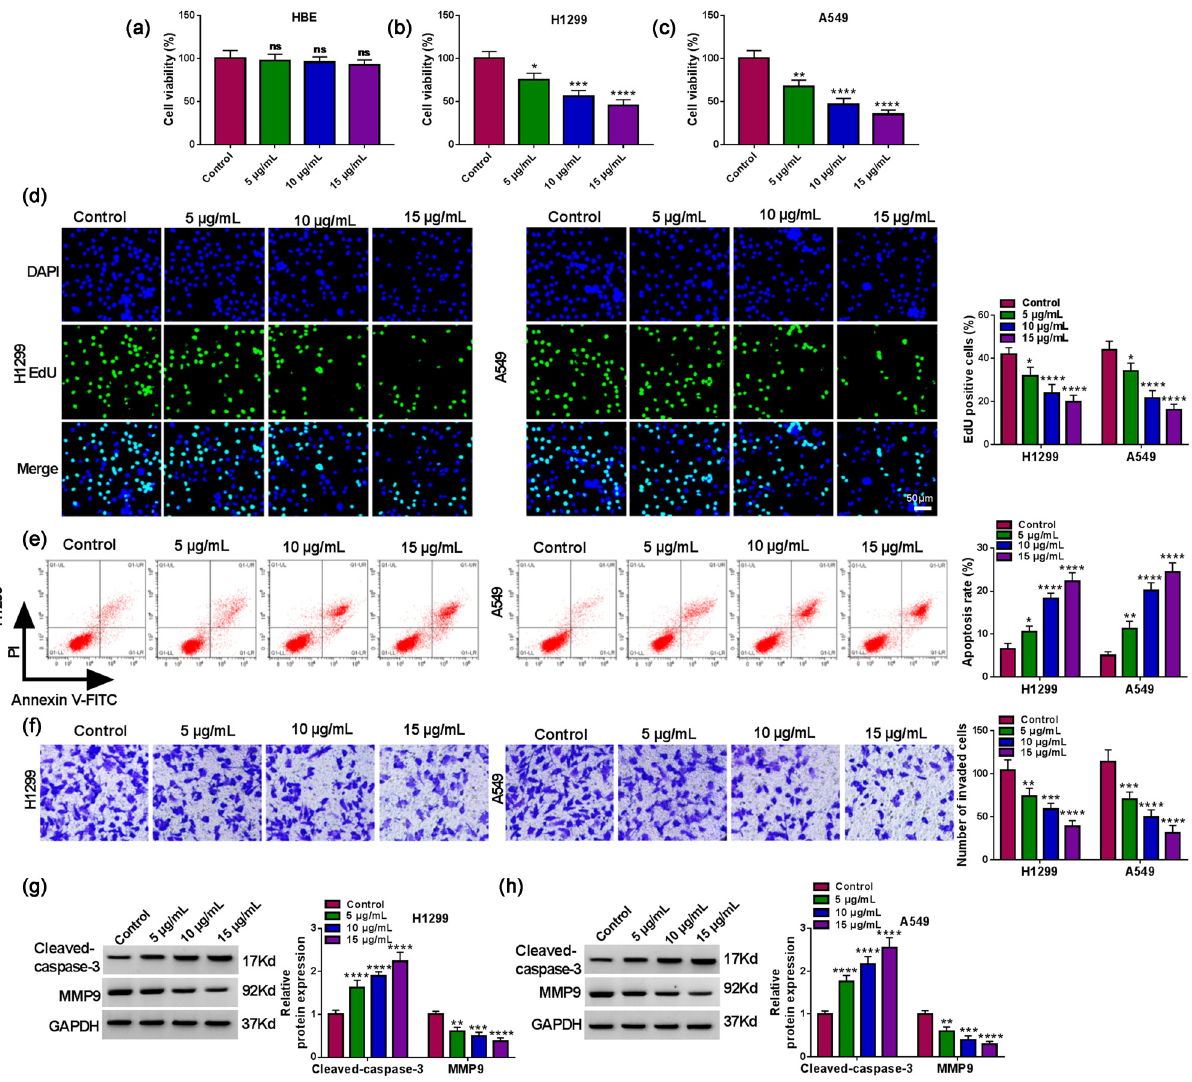
Figure 1: Propofol curbed cell proliferation, invasion, and induced cell apoptosis in NSCLC cells. ( a ) Cell viability was evaluated by MTT assays. The HBE cell line was subjected to 5, 10, and 15 μ g/mL propofol for 48 h ( n = 3 ) . ( b – f ) Viability, proliferation, apoptosis, and invasion of NSCLC cells treated with 5, 10, and 15 μ g/mL propofol were determined using MTT, EdU, fl ow cytometry, and transwell assays ( n = 3 ) . ( g and h ) Relative protein levels of Cleaved - caspase3 and MMP9 in NSCLC cells treated with 5, 10, and 15 μ g/mL propofol were detected using western blotting ( n = 3 ) . * P < 0.01, ** P < 0.01, *** P < 0.001, and **** P <